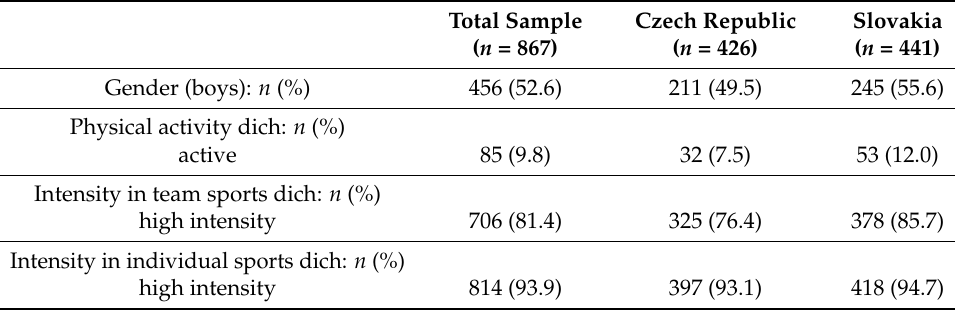
Table 4. Sample dichotomization considering activity type (team or individual